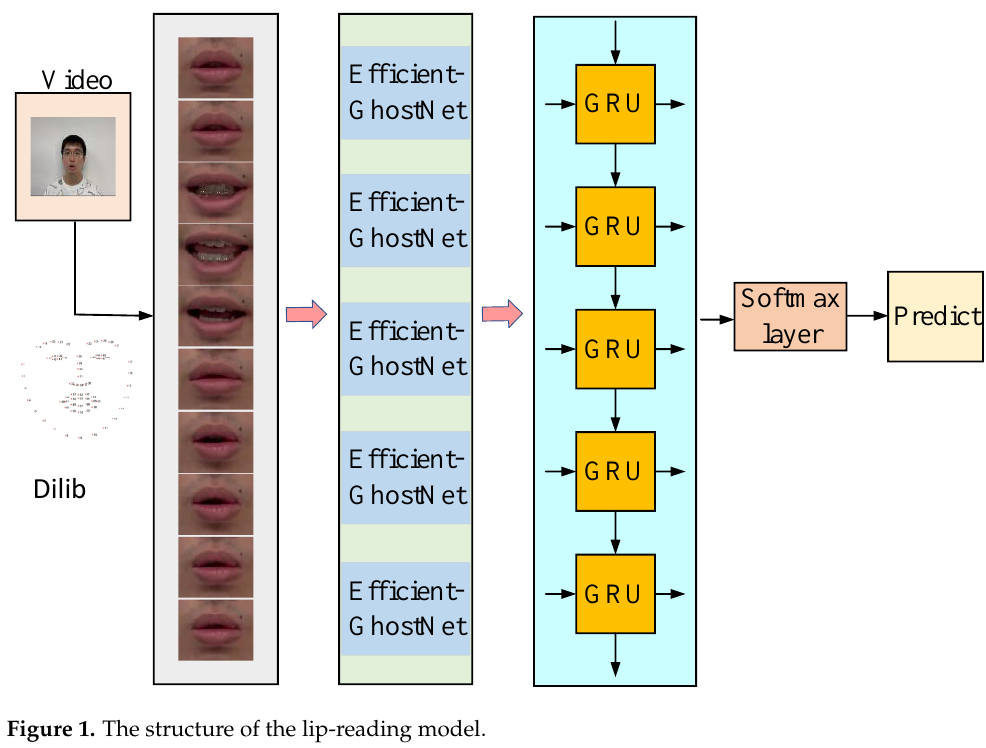
Figure 1. The structure of the lip-reading model.